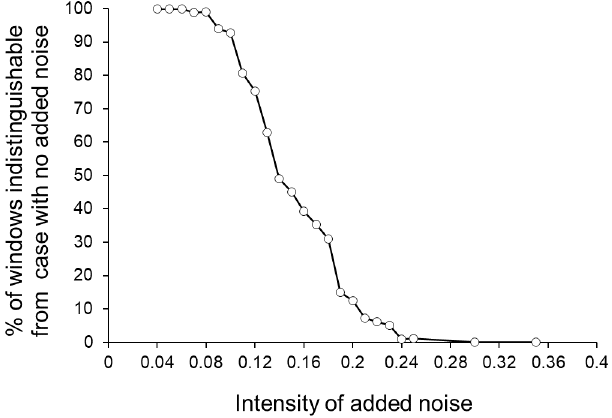
Figure 4. The percentage of the 50-data windows (shifted by 50 data steps) of the crack fusion model with added noise that are indis- tinguishable from the initial condition (system with no added noise).